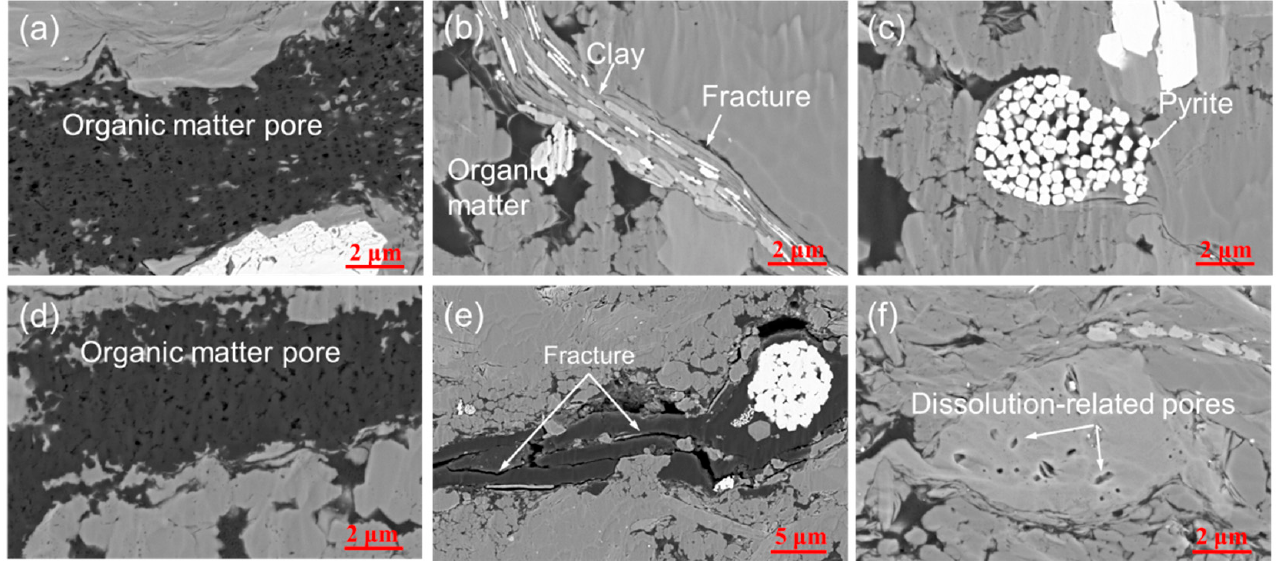
Figure 6. Pore types of shales in Wufeng–Longmaxi Formation of the Anchang Syncline. ( a ) Organic matter pores; ( b ) Fracture between clay minerals and framework minerals; ( c ) Intercrystalline pores in the pyrite framboid; ( d ) Organic matter pores; ( e ) Fractures in organic matter particles; ( f ) Dissolution-related pores in carbonates.